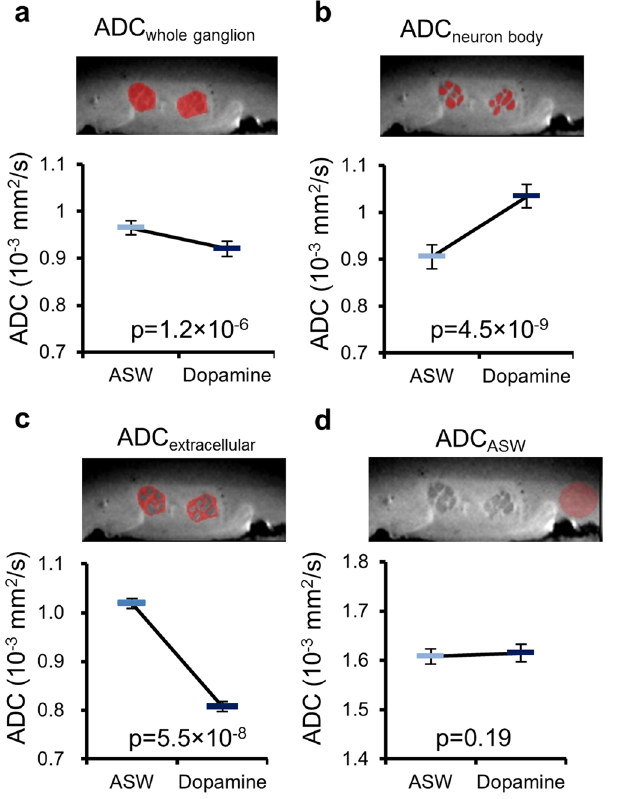
Figure 3. ADC decreased at ganglia level and increased at cellular level after dopamine stimulation. Average ADC changes after dopamine stimulation in the ganglia tissue ( a ), neuron bodies ( b ), extracellular region ( c ), and ASW regions ( d ). ROIs (red) of the ganglia tissue, neuron bodies, extracellular region, and ASW region were shown on the structural RARE image. The ADC values in the ganglia tissue were averaged over both sides of the ganglia in 7 Aplysia (14 ROIs). The ADC values of neuron bodies were averaged over all neurons (B1, B2, B3, B6, B9, B38, and B39) of each side of the 14 ganglia. The ADC value of ASW region was averaged over ASW ROIs in 7 samples. The statistical analysis was performed using a bilateral paired t-test. Bars plots exhibited mean ±